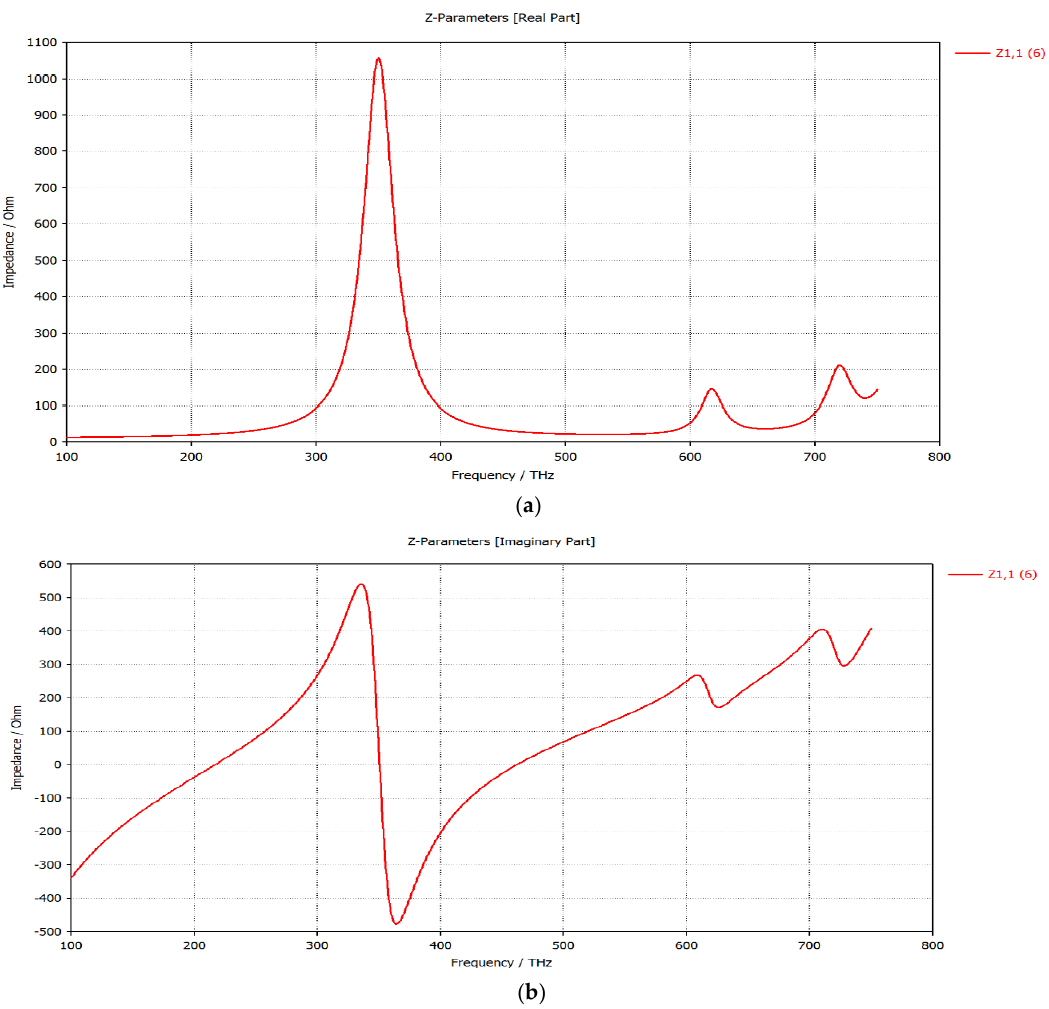
Figure 12. ( a ) Input resistance of the proposed antenna; ( b ) Input Reactance of the proposed antenna.